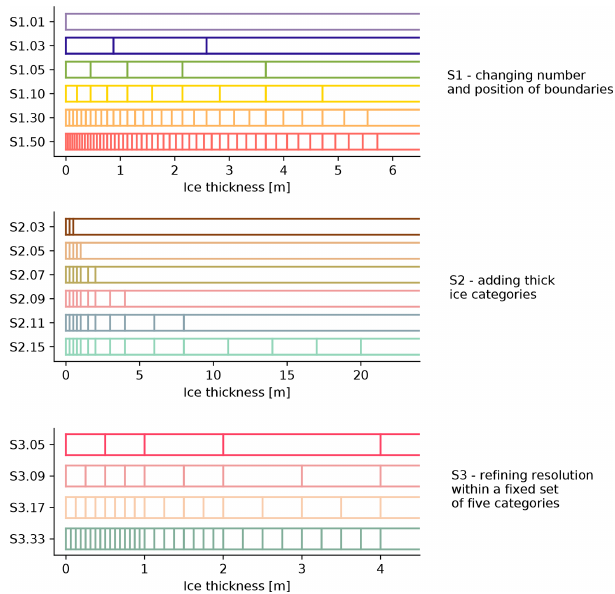
Figure 1. Ice thickness category boundaries in the three sets of sen- sitivity experiments. The upper boundary of the last category is al- ways set to 99.0m. Note that the ice thickness scale is different in the three panels. Because the ITD discretization in the third set of experiments (S3) branches from experiment S2.09 of the second set, that experiment is repeated in the list but labeled as